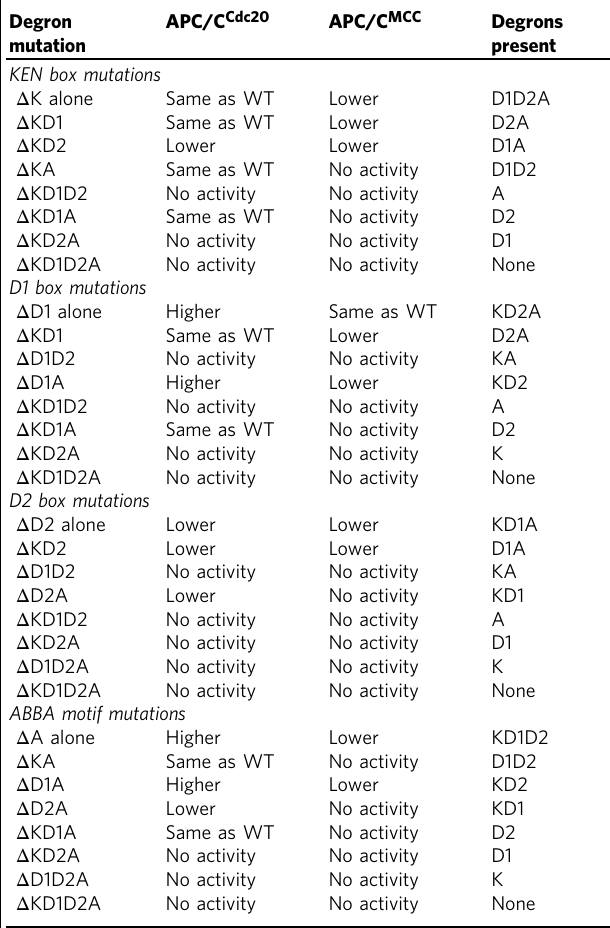
Table 1 Summary of the effects of cyclin A2